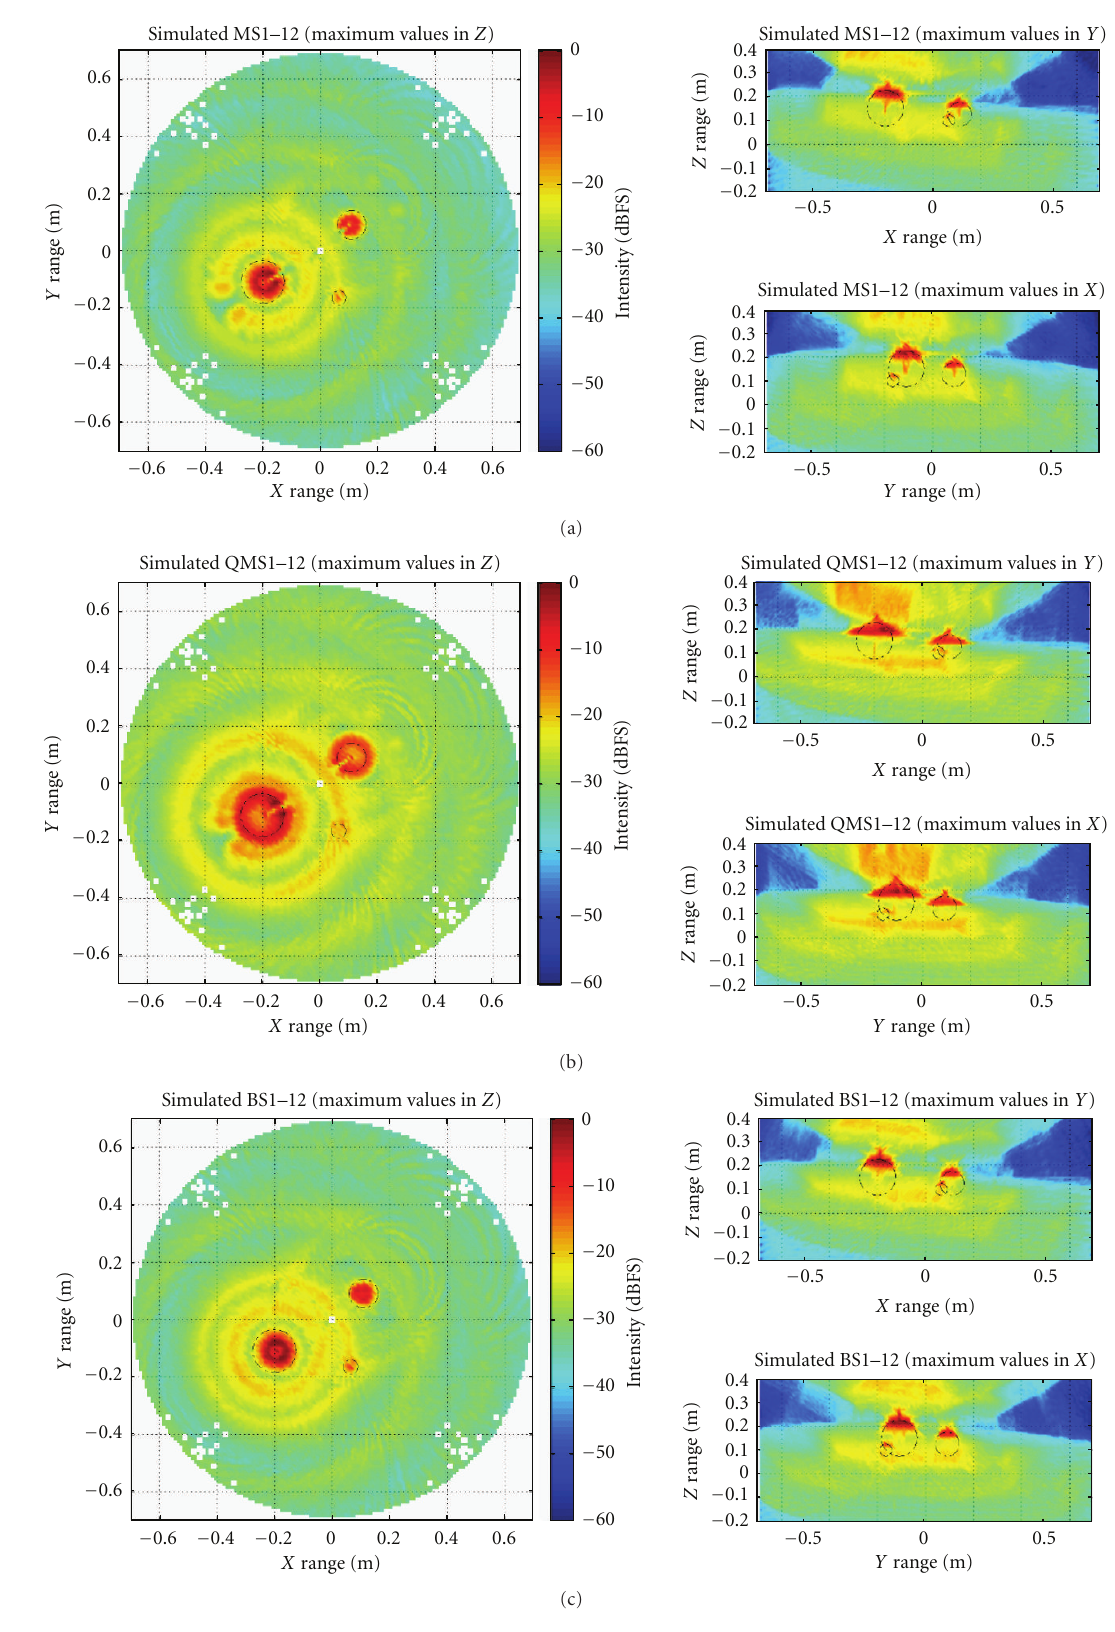
Figure 18: Simulated tomographic reconstruction of the spherical targets listed in Table 2. (a) (Q)MS antennas, (Q)MS algorithm. (b): BS antennas, (Q)MS algorithm. (c) BS antennas, BS